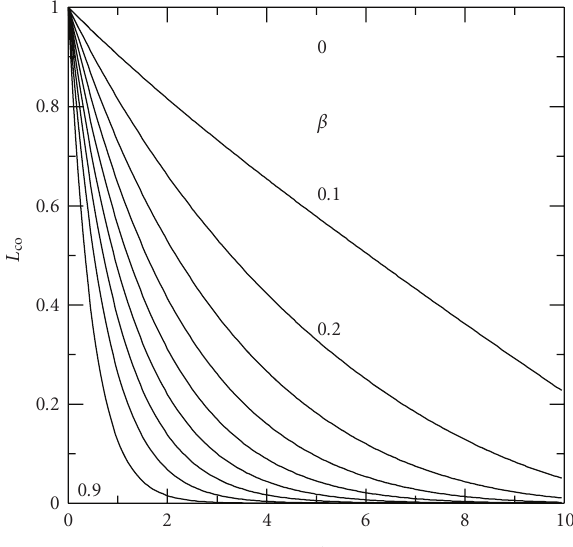
Figure 2: Comoving luminosity for relativistic spherical flows in the RE case without heating and cooling. The values of β are from 0 to 0.9 in steps of 0.1 from top to bottom. The optical depth τ c at the core radius is set to be